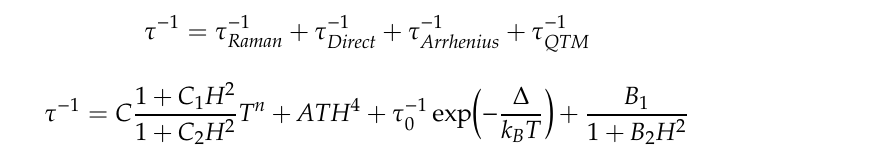
= 222(20) T − 2 , C = 461(50) T − 2 , C = 652(50) s − 1 · K − 4.8 , 2 O: C 1 2